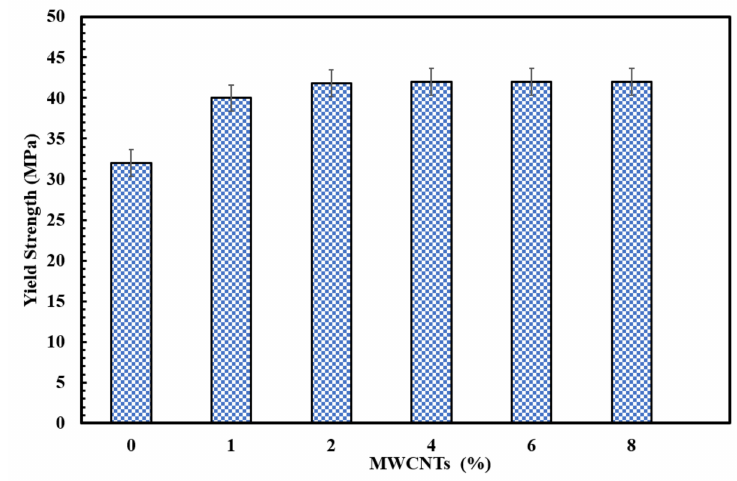
Figure 3. Effect of MWCNTs on the yield strength of PP-GF composites.